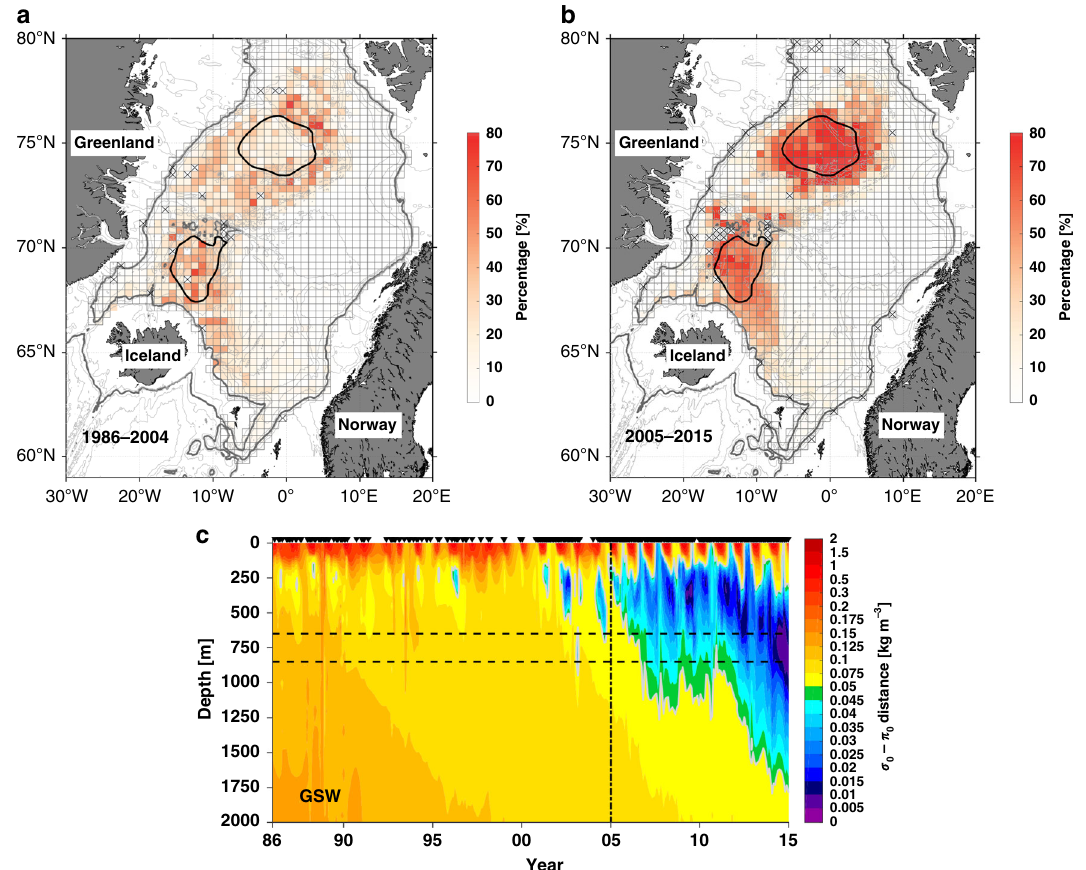
Fig. 5 Long-term variability of the densest over fl ow water. Relative layer thickness (in percentage, colors) of the small σ 0 – π 0 distance water ( ≤ 0.05kgm − 3 ) in the upper 650m of Nordic Seas for the time period ( a ) 1986 – 2004, and ( b ) 2005 – 2015. The thick gray contours show the 650m isobath. The bins marked with an X denote the regions with no data coverage. c Evolution of σ 0 – π 0 distances between the NIJ transport mode and the water within upper 2000m of the Greenland Sea gyre (the black contour in a and b ). The two horizontal dashed lines indicate the sill depths of Denmark Strait (650m) and the Faroe Bank Channel (850m). The vertical dashed line denotes year 2005. The gray contours denote σ 0 – π 0 distances = 0.05kgm − 3